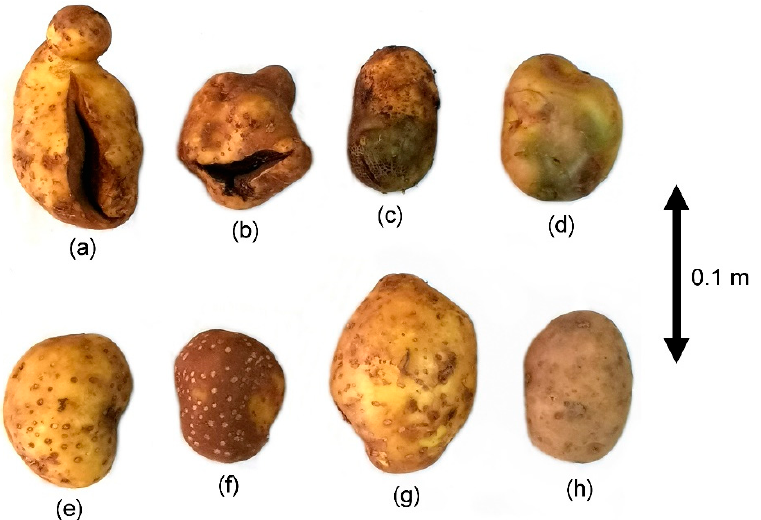
Figure 2. Selected tubers displaying the challenges of the wood-fiber-based production observed during the experiment, including deformation ( a , b ), cracking ( a , b ), delayed ripening ( c , d ), over- grown lenticels ( e , f ), skin degradation ( f ) and increased growth ( g ); field-grown tuber is given for reference ( h ).